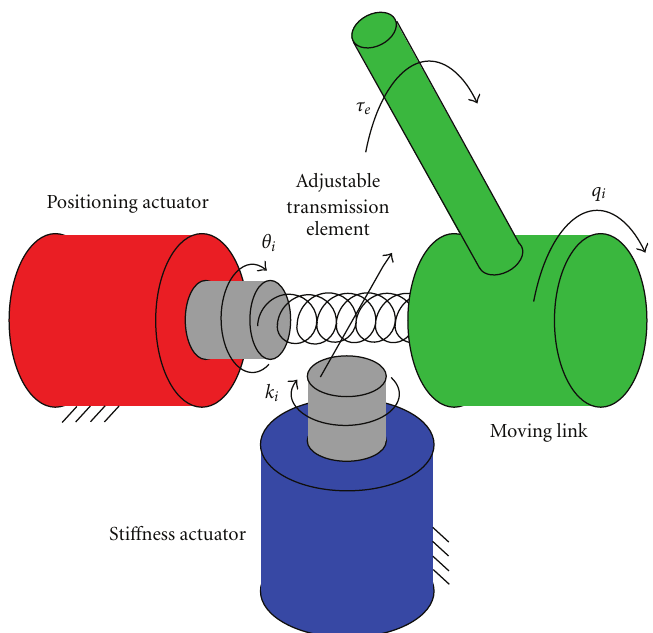
Figure 1: Working principle scheme of a variable sti ff ness